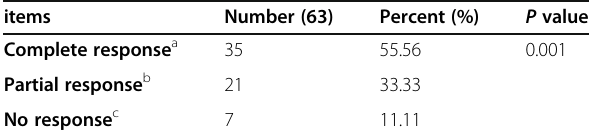
Table 3 Evaluation of platelet counts in response of H . pylori eradication therapy in HpSA-positive patients ( N =